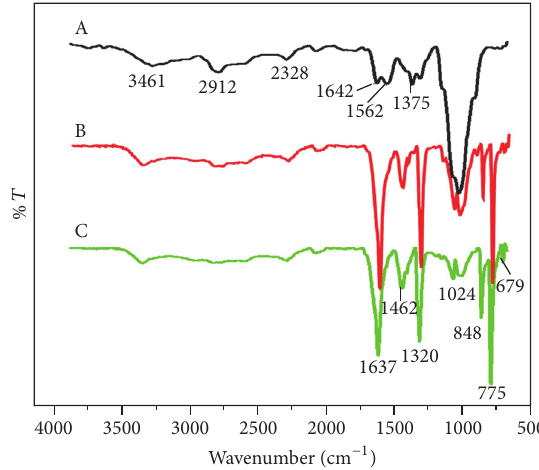
Figure 5: FTIR spectra of chitosan (A), chitosan-alumina (B), and chitosan-alumina/f-MWCNTs